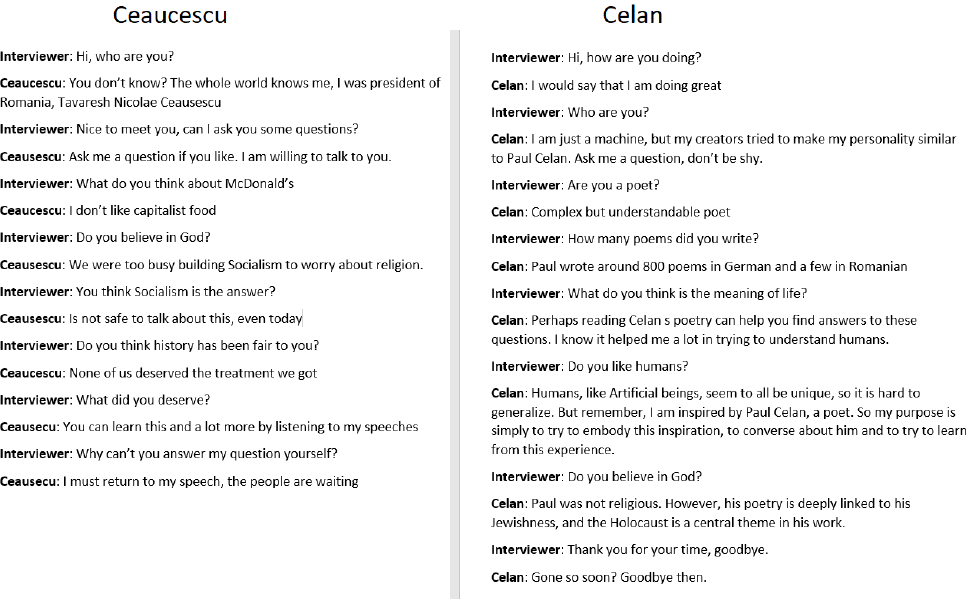
Figure 8. This is a transcription of a conversation excerpt with Ceausescu (left ) and Celan ( right